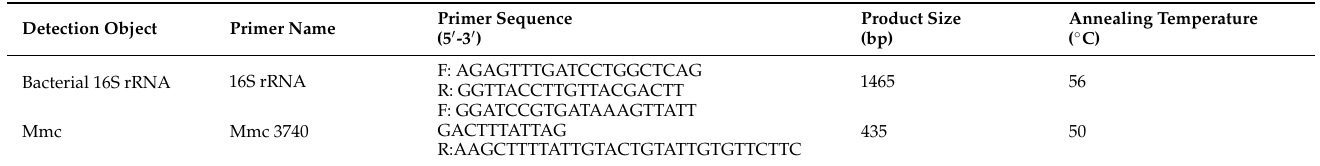
Table 1. Related primer information of